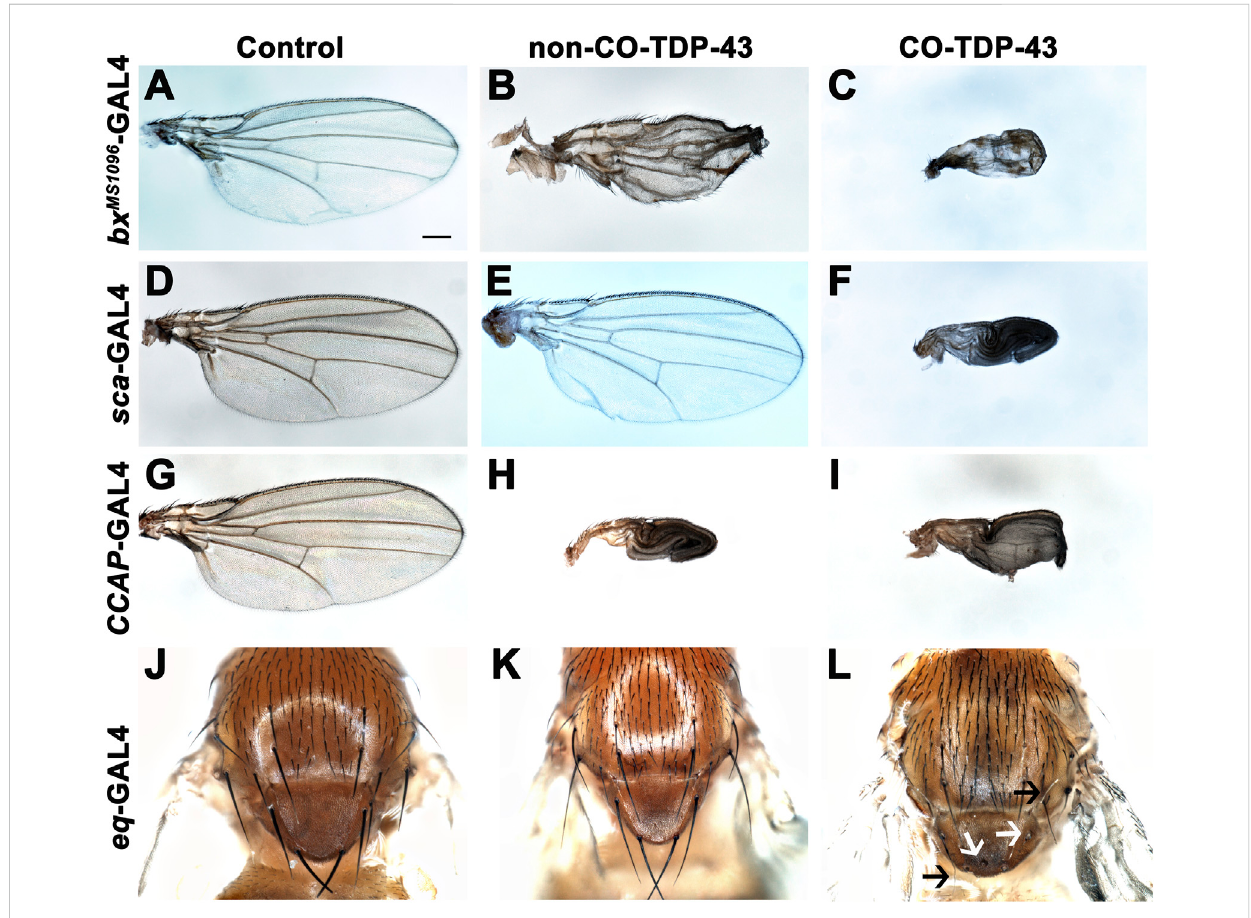
FIGURE 2 MisexpressionofcodonoptimizedTDP-43leadsto wingexpansion andswellingdefectsaswellassingedandlossofbristlesinthe fl ynotum. (A – C) CO-TDP-43 expressed in the wings using the wing-speci fi c driver bx MS1096 -GAL4 leads to pharate adults with smaller, swollen and necrotic wings (C) , as compared to healthy, viable adults expressing human wild-type non-CO-TDP-43 with crumpled wings (B) and normal wings with the driver alone (A) . (D – F) Using sca -GAL4 driver, human wild-type non-CO-TDP-43 fl ies (E) have normal wings, similar to controls with thedriver alone (D) ,whileCO- TDP-43 causes pharate adults with smaller, necrotic wings with expansion defect (F) . (G – I) CCAP -GAL4, expressed in CCAP/bursicon neurons in the ventral nerve cord and the subesophageal ganglion in the adult brain, driven expression of CO-TDP-43 (I) as well as human wild-type non-CO-TDP- 43 (H) also exhibit similar wing expansion defects, compared to the driver alone (G) . (J – L) A bristle speci fi c driver, eq -GAL4, causes a dramatic loss of bristles (white arrows) and singed bristles (black arrows) with CO-TDP-43 fl ies (L) , while human wild-type non-CO-TDP-43 (K) and driver alone (J) developnormalbristles.Scalebar:200um.Genotypes: (A) w 1118 , bx MS1096 -GAL4/+;+;+, (B) w 1118 , bx MS1096 -GAL4/+;+;UAS-hTDP-43 WT /+, (C) w 1118 , bx MS1096 - GAL4/+; +;UAS-TDP-43 CO /+, (D) w 1118 /+; sca -GAL4/+; +, (E) w 1118 /+; sca -GAL4/+; UAS-hTDP-43 WT /+, (F) w 1118 /+; sca -GAL4/+; UAS-TDP-43 CO /+, (G) y 1 ,w*/+; CCAP -GAL4/+;+, (H) y 1 ,w*/+; CCAP -GAL4/+;UAS-hTDP-43 WT /+, (I) y 1 ,w*/+; CCAP -GAL4/+;UAS-TDP-43 CO /+, (J) w 1118 /+; eq -GAL4/+;+;+, (K) w 1118 /+; eq -GAL4/+; +;UAS-hTDP-43 WT /+, (L) w 1118 /+; eq -GAL4/+; +; UAS-TDP-43 CO